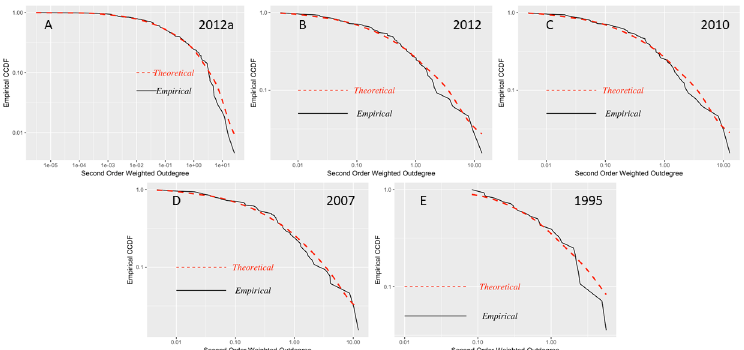
Fig 7. CCDF second-order weighted outdegree input-output matrices 1995–2012. (A) Detailedmatrix 2012, 245 economicsectors. (B) Summary matrix 2012, 71 economicsectors. (C) Matrix 2010, 71 economic sectors. (D) Matrix 2007, 71 economicsectors. (E) Matrix 1995, 34 economicsectors. Log-log plots of the empiricalcounter-cumulative density functionsof the weightedsecond-order outdegree.